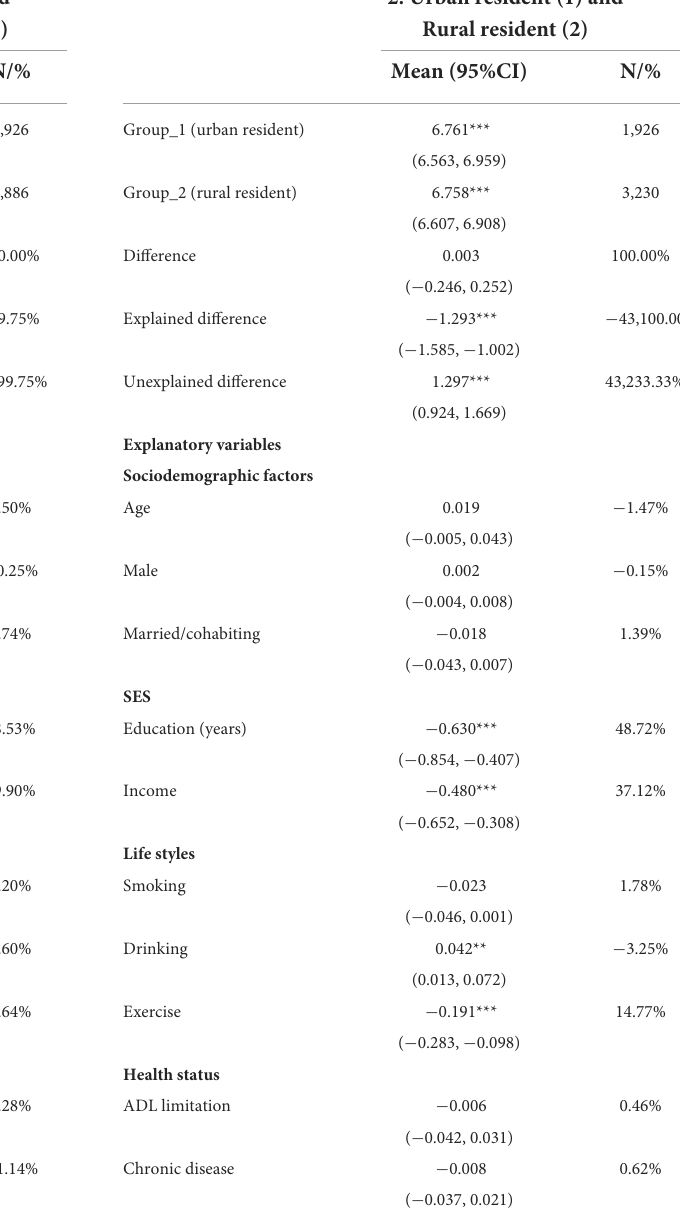
TABLE 5 Blinder-Oaxaca decomposition of the gap in depressive symptoms between urban resident and rural resident samples